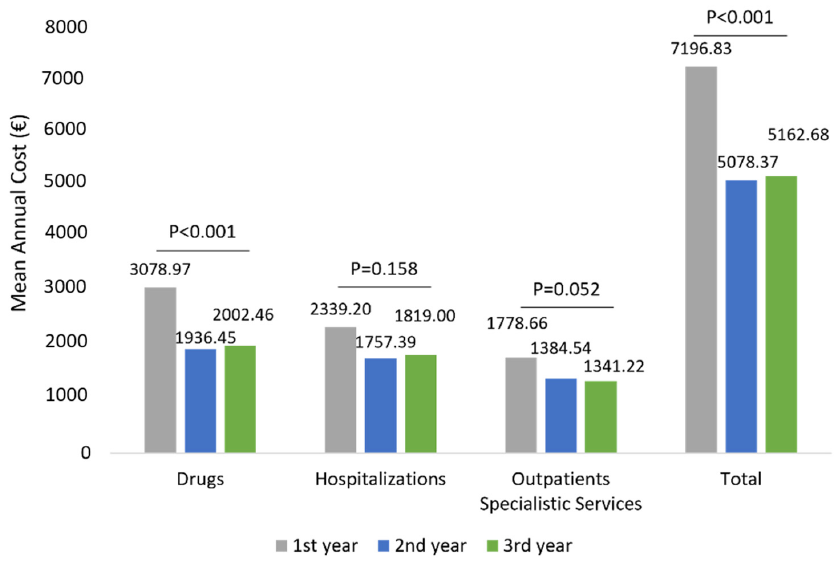
Figure 6. Health care-related costs during the follow-up among patients of other ocular disease- cohorts.